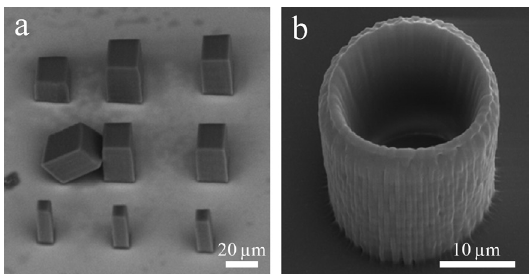
Figure 6. SEM images of microstructures with different sizes and heights (a) and of an open cylindrical microstructure (b).